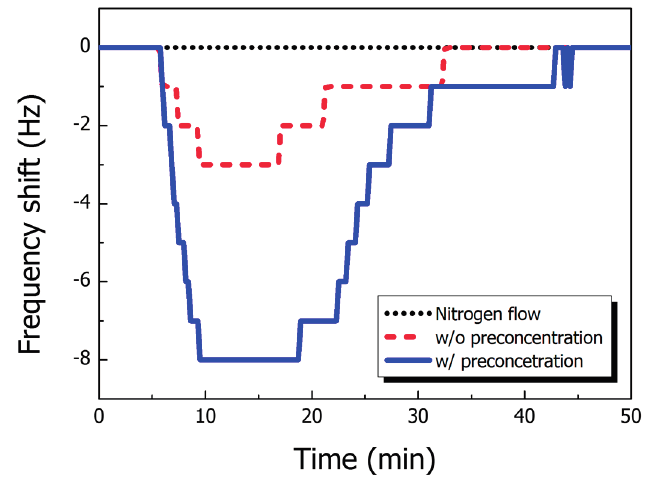
Figure 5. Relative signal response with different sample preprocessing environments: pure N 2 flow (black dotted line), direct injection of 160 ppb 2,4-DNT (red dashed line), and 2,4-DNT sample preprocessing with µPC (blue solid